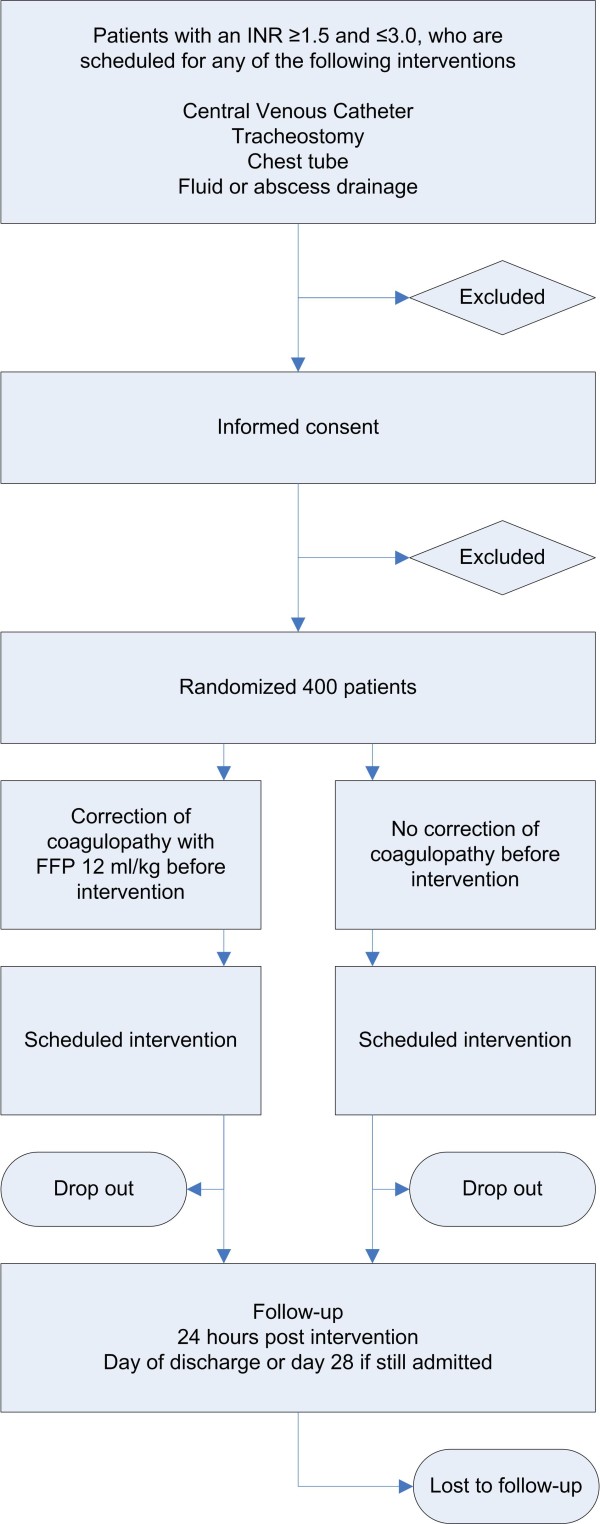
CONSORT diagram.